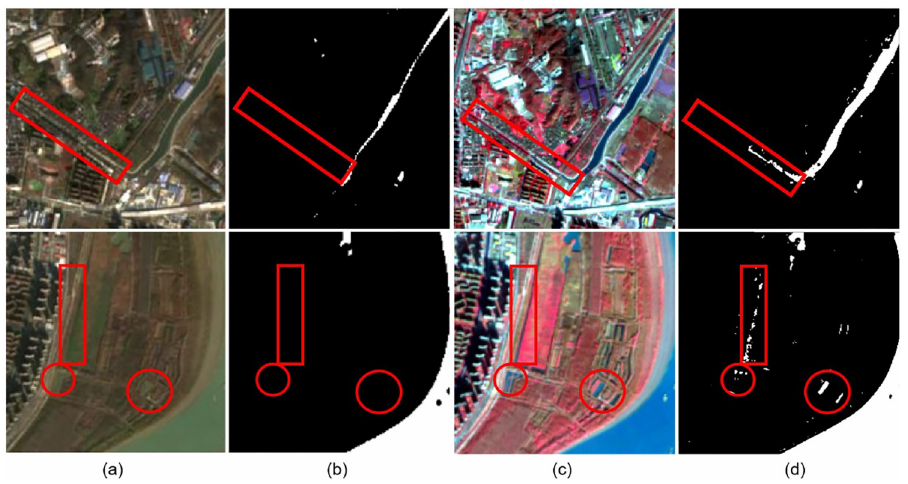
Fig 14. Results of our proposed method on two selected samples from the testing dataset. ( a ) Original remote sensing images containing tiny water bodies; ( b ) extraction results of existing methods; ( c ) generated remote sensing images; ( d ) extraction results of our proposed method. Reprinted from www.gscloud.cn under a CC BY license, with permission from Dr. Qinghui Lin, original copyright